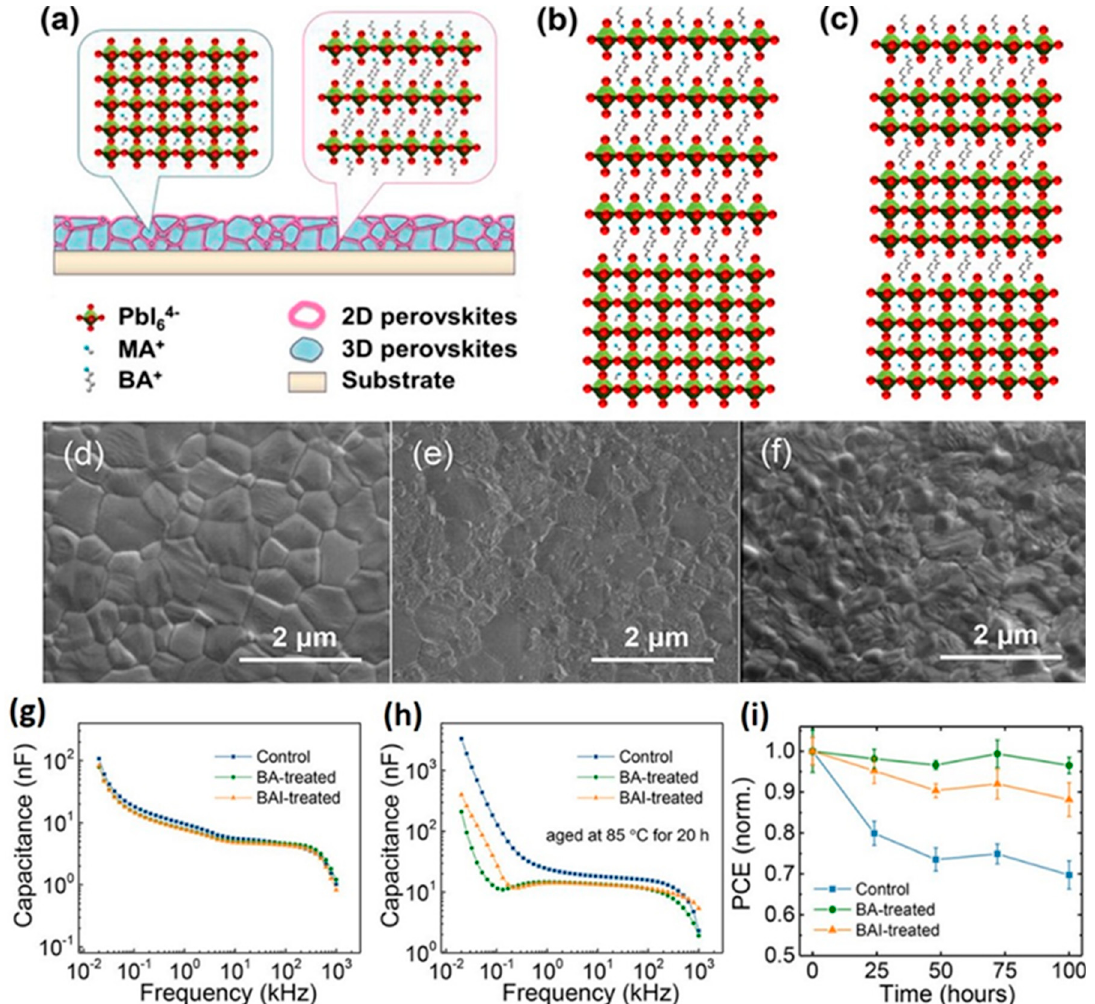
Figure 11. ( a ) A schematic of 2D/3D stacking structure obtained from BA-treated perovskite film. ( b , c ) 2D/3D molecular junctions on the surface and at grain boundaries of 3D perovskite films with BA and BAI treatments, respectively. SEM images of (d) MAPbI 3 films, ( e ) BA-treated MAPbI 3 films, and ( f ) BAI-treated MAPbI 3 films. Capacitance − frequency spectra ( g ) before and ( h ) after thermal stress at 85 °C for 20 h of the control, BA-treated, and BAI-treated devices; ( i ) Time evolution of normalized PCE under thermal stress. Reprinted with permission from [74]. Copyright (2018) American Chemical Society.